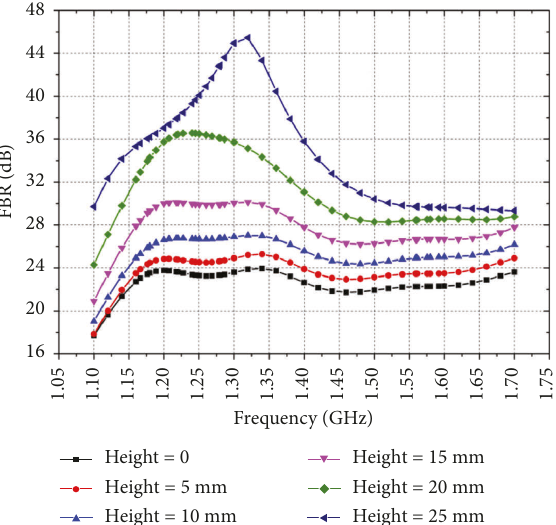
Figure 5: FBR changes with trapezoidal height.